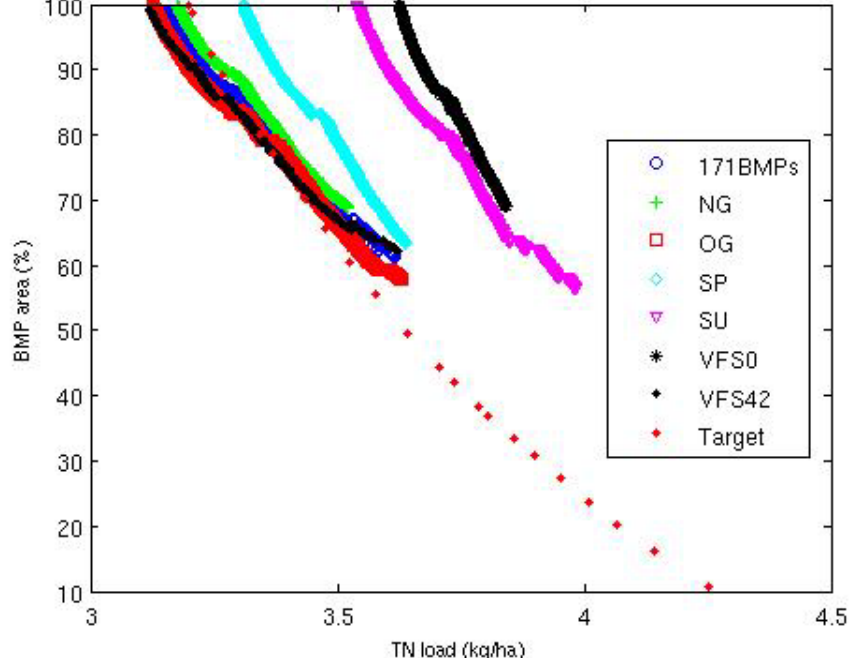
Figure 6. Comparison of the Pareto-optimal fronts of different optimization models after the final generation and the solutions obtained from the targeting method for total nitrogen (TN) and total phosphorus (TP)